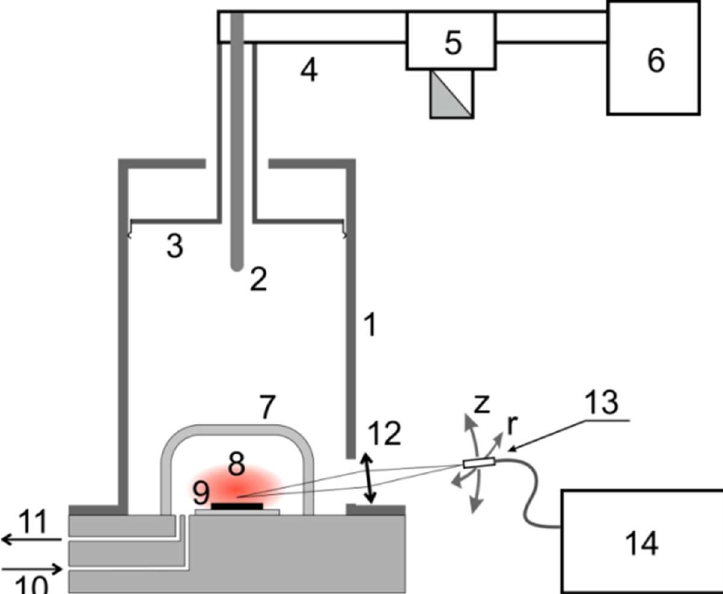
Figure 1. Block-scheme of the CVD reactor: 1—a wall of the microwave resonator; 2—adjustable communication device based on a coaxial waveguide; 3—the upper movable wall of the resonator; 4—rectangular waveguide; 5—circulator; 6—magnetron; 7—quartz flask; 8—plasma; 9—silicon substrate; 10—supply of the gas mixture; 11—pumping out; 12—focusing lens; 13—movable light guide; 14—HORIBA Jobin Yvon FHR-1000